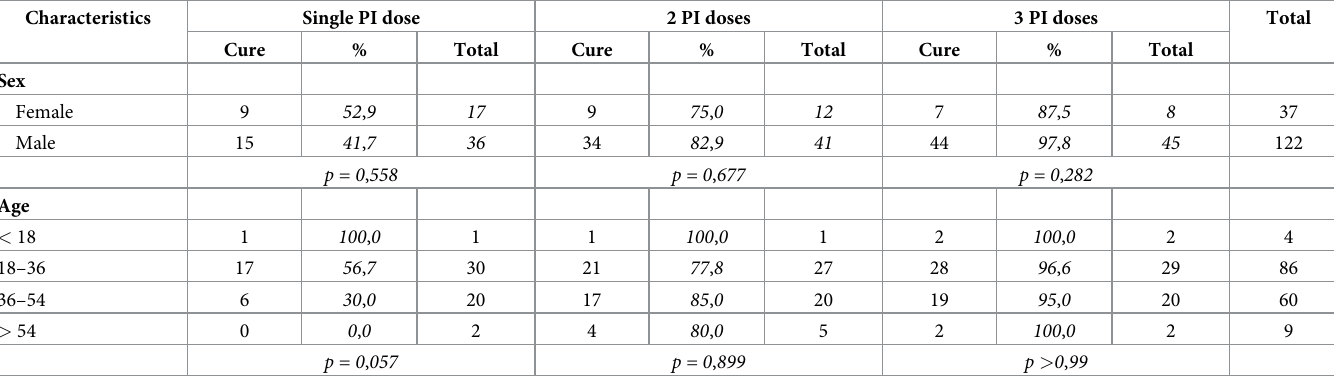
Table 3. Responses to treatment at follow-up six months after the treatment for ACL according to sex and age of patients in Manaus in 2013–2015.